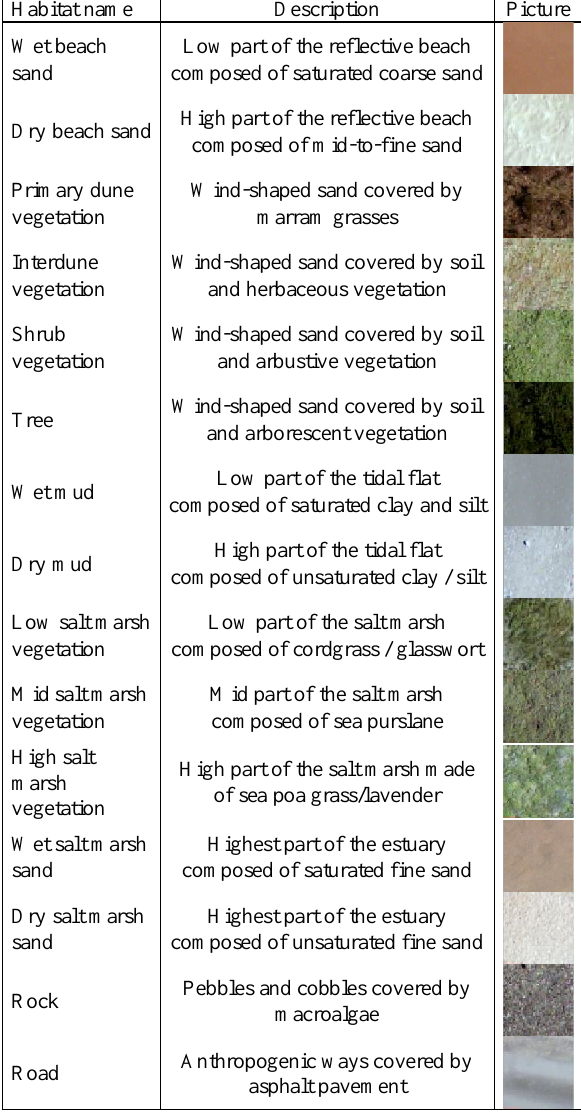
Table 2 . Habitat names and description of the 15 classes investigated in the study site.